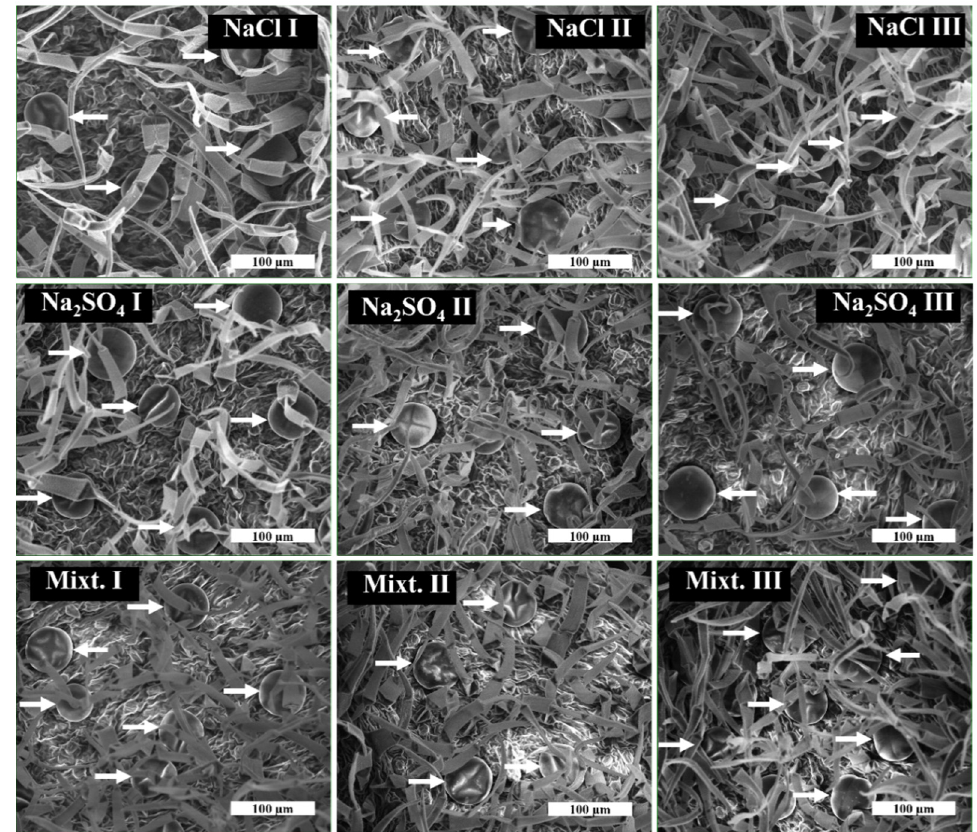
Figure 3. ESEM micro-images of the variants with the glandular trichomes indicated with arrows.